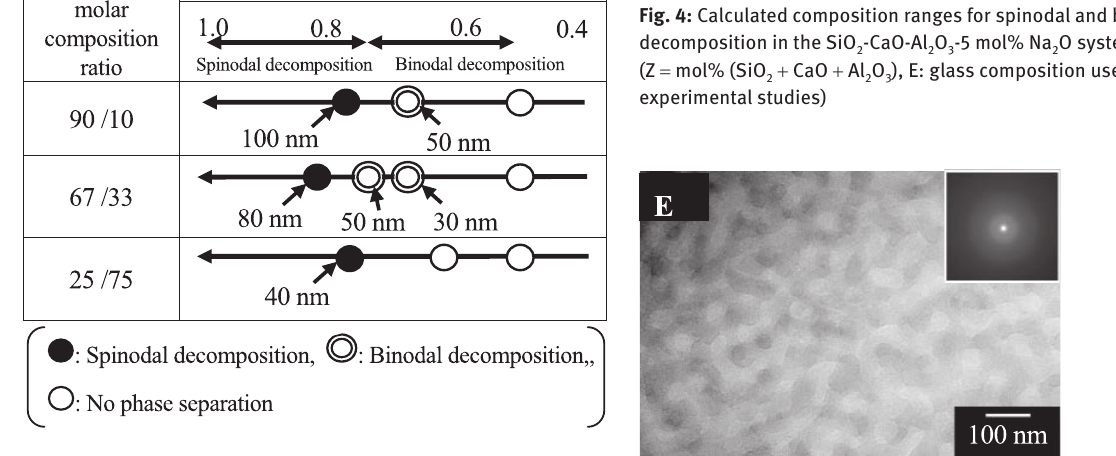
Fig. 5: Transmission electron micrograph of glass E annealed at 993 K for 96